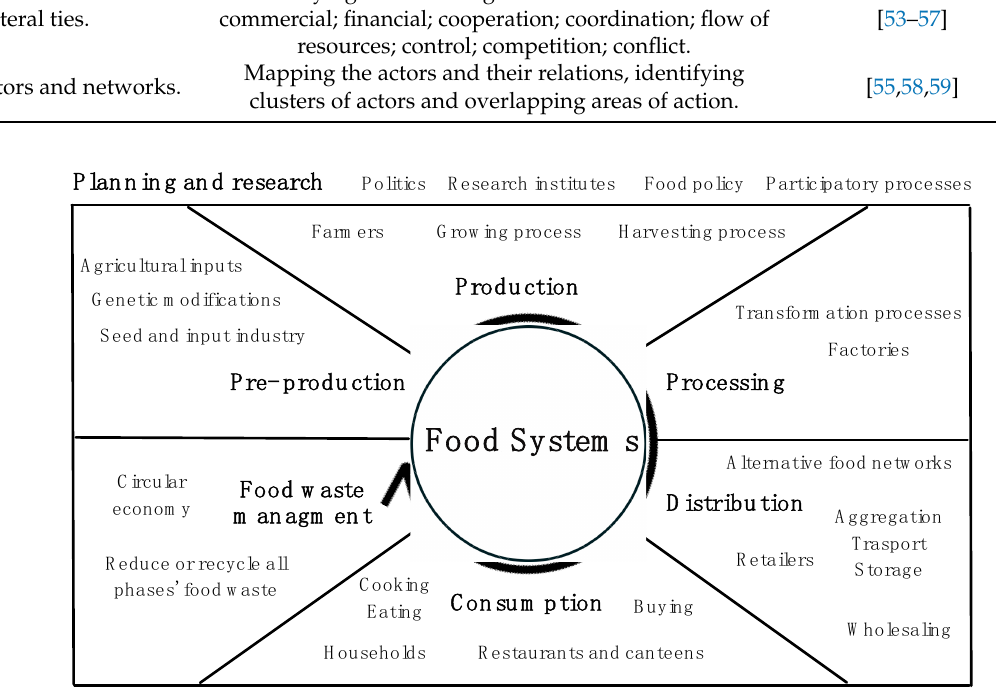
Methodology’s Sections Activities to Carry Out